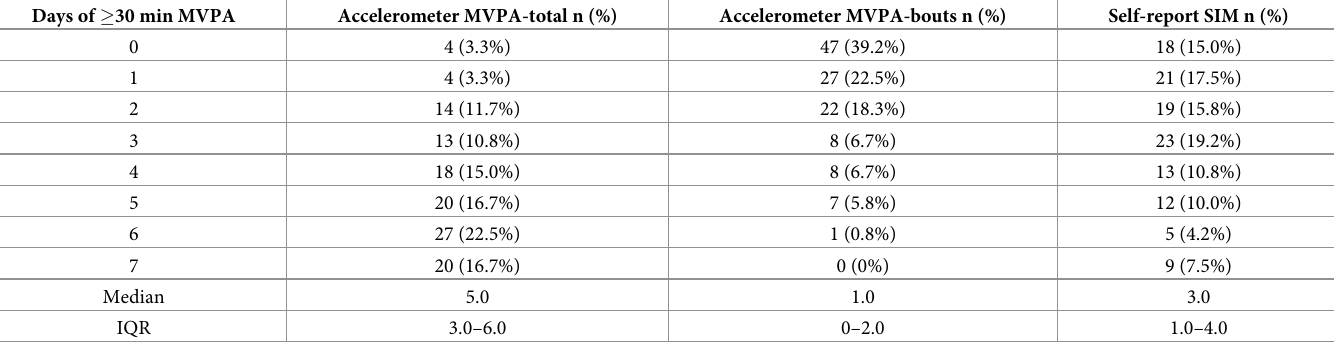
Table 1. Frequency of days with � 30 minutes of moderate-to-vigorous intensity physical activity (MVPA) at a single time point as measured using accelerometry and single item measure (SIM) self-report.